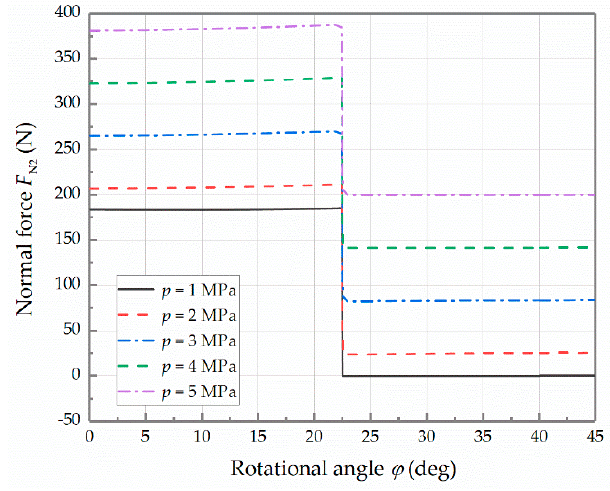
Figure 11. Curves of the normal force F N2 at different pressures.